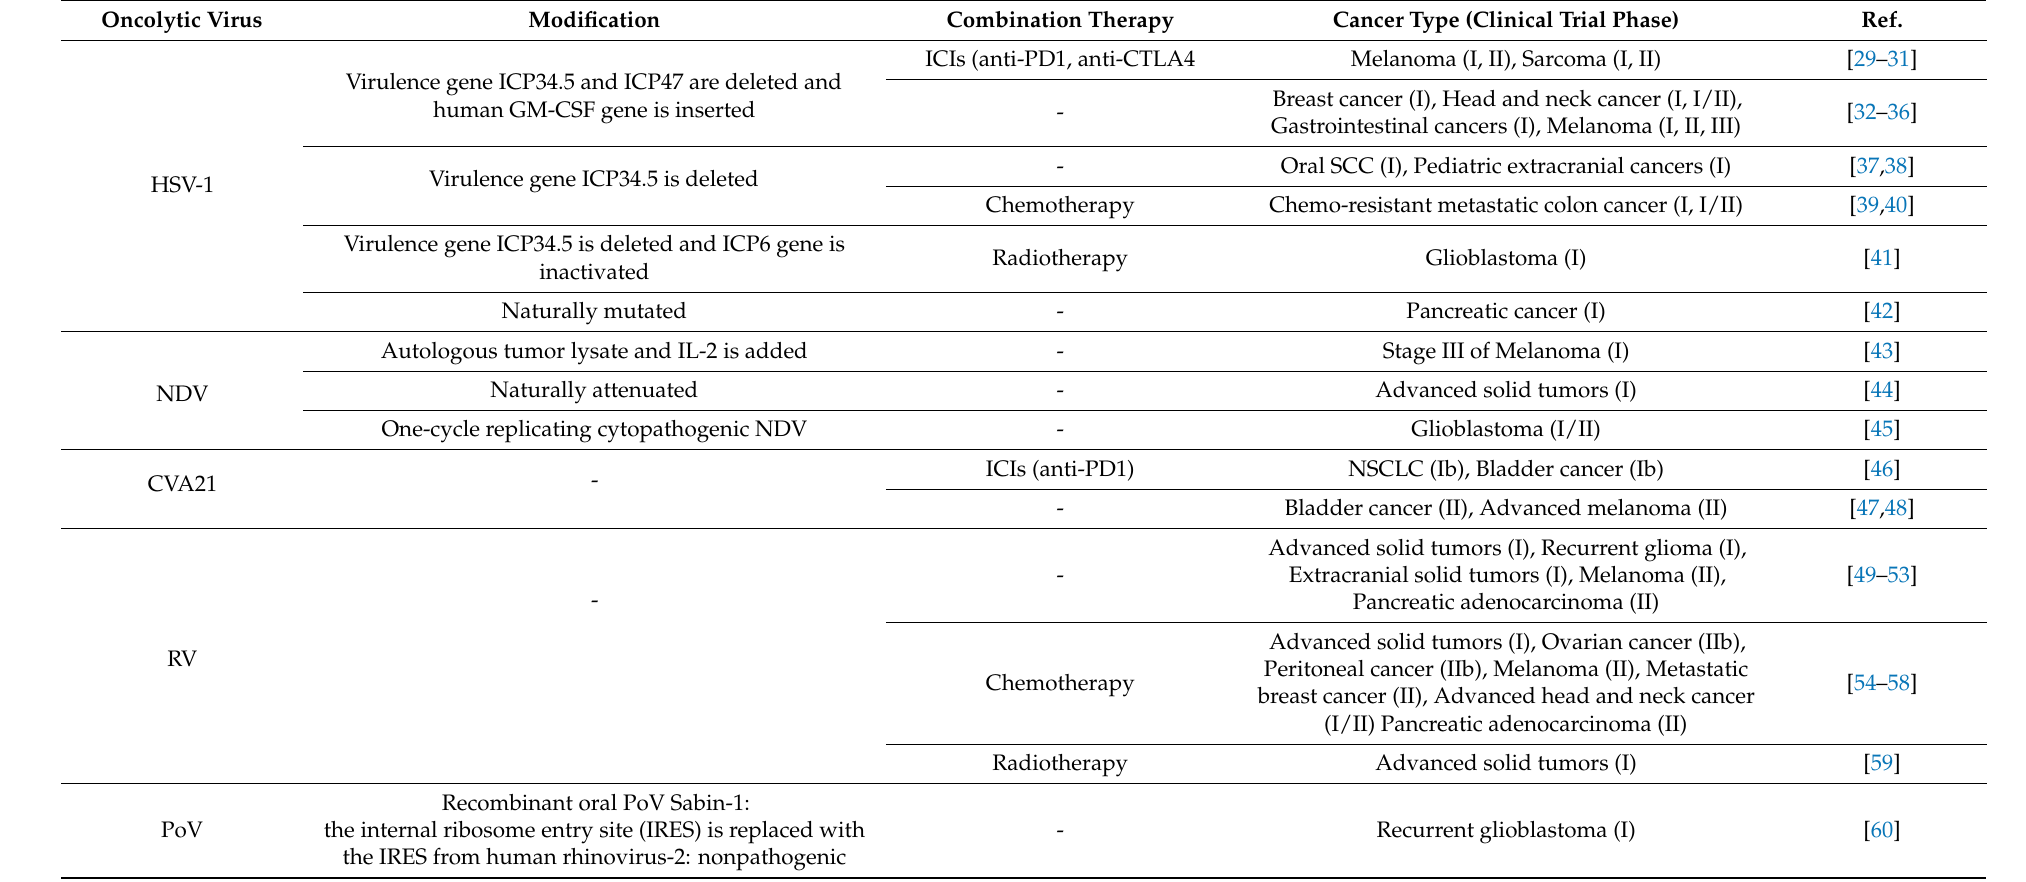
Table 1. Oncolytic viruses that reached the clinical